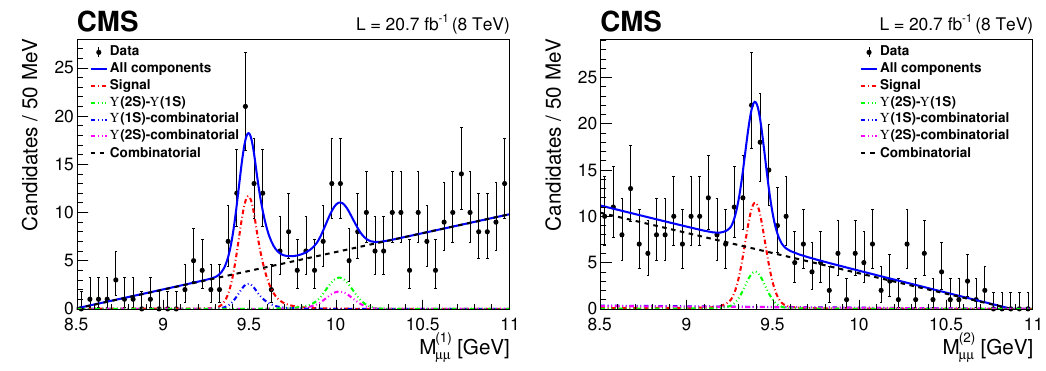
Figure 2 . Invariant mass distributions of the higher-mass muon pair (left) and the lower-mass muon pair (right). The data are shown by the points. The di(cid:11)erent curves show the contributions of the various event categories from the